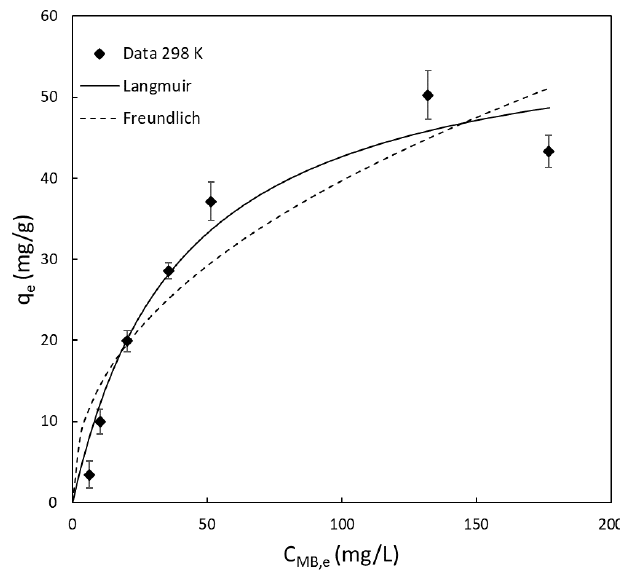
Figure 5. Langmuir and Freundlich isotherms obtained by a non-linear fitting of the adsorption data of MB using yerba mate at 298 K. The error bars represent the standard deviation.